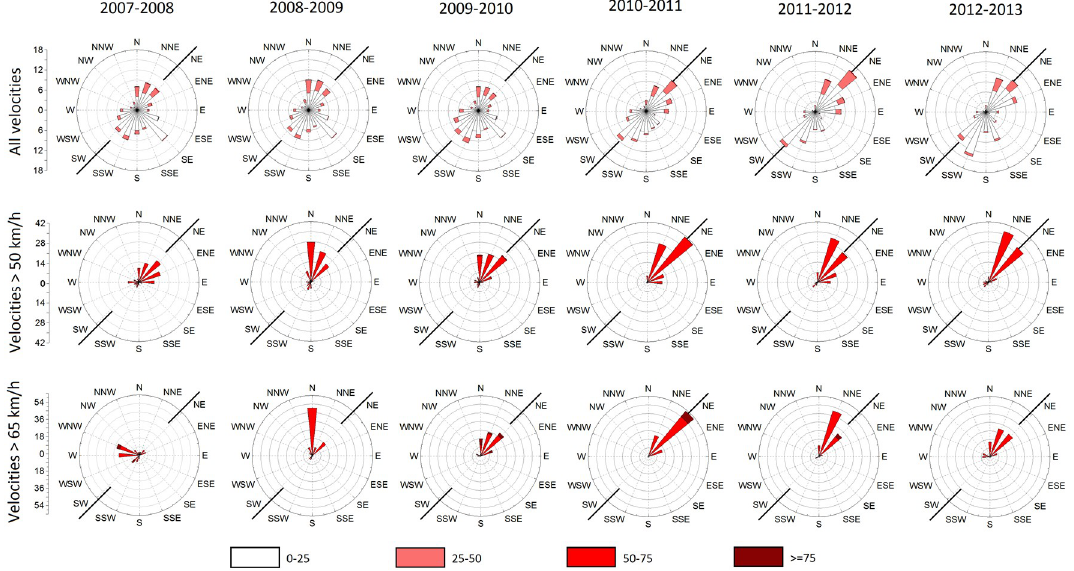
Figure 6. Rose diagrams of the wind distribution during the six intervals defined by the bridge measurement surveys. Scale indicates percentage of occurrence. Two black lines in NE-SW direction indicate the main bridge axis. Top: all winds; middle: winds >50 km/h; bottom: winds >65 km/h. Mark that strong northerly winds with a significant component normal to the bridge axis are confined to the interval 2007–2008, when most of the damage